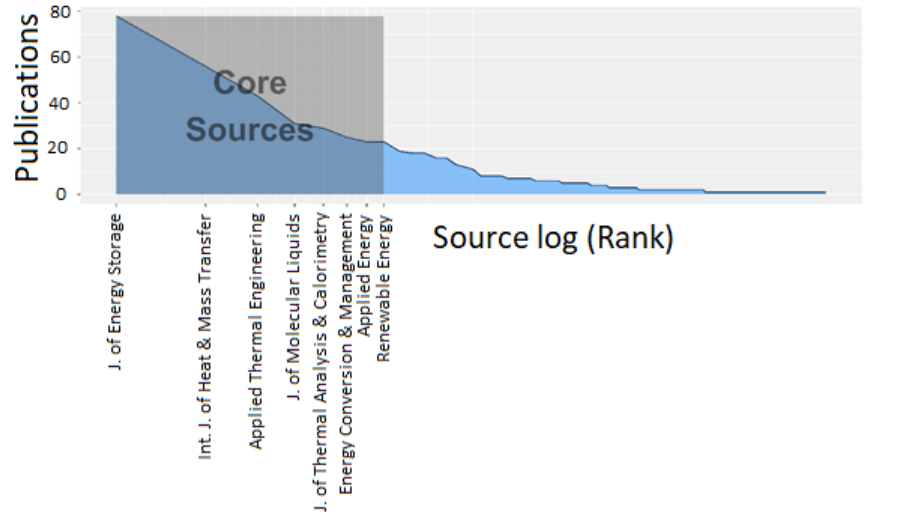
Figure 8. Bradford’s Law of Scattering.